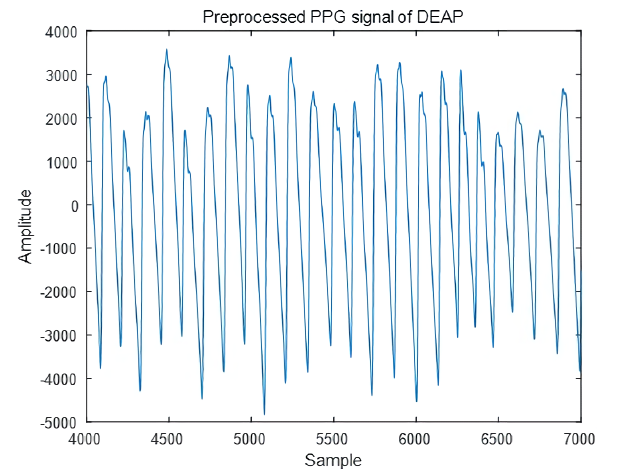
Figure 6. Eliminating finger movement noise for the DEAP